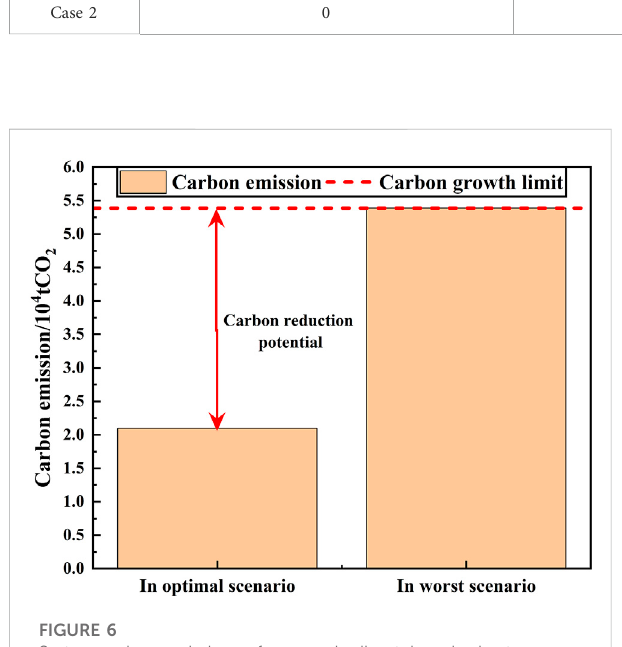
FIGURE 6 System carbon emissions of economic dispatch and robust dispatch with wind turbine capacity of Case 1.